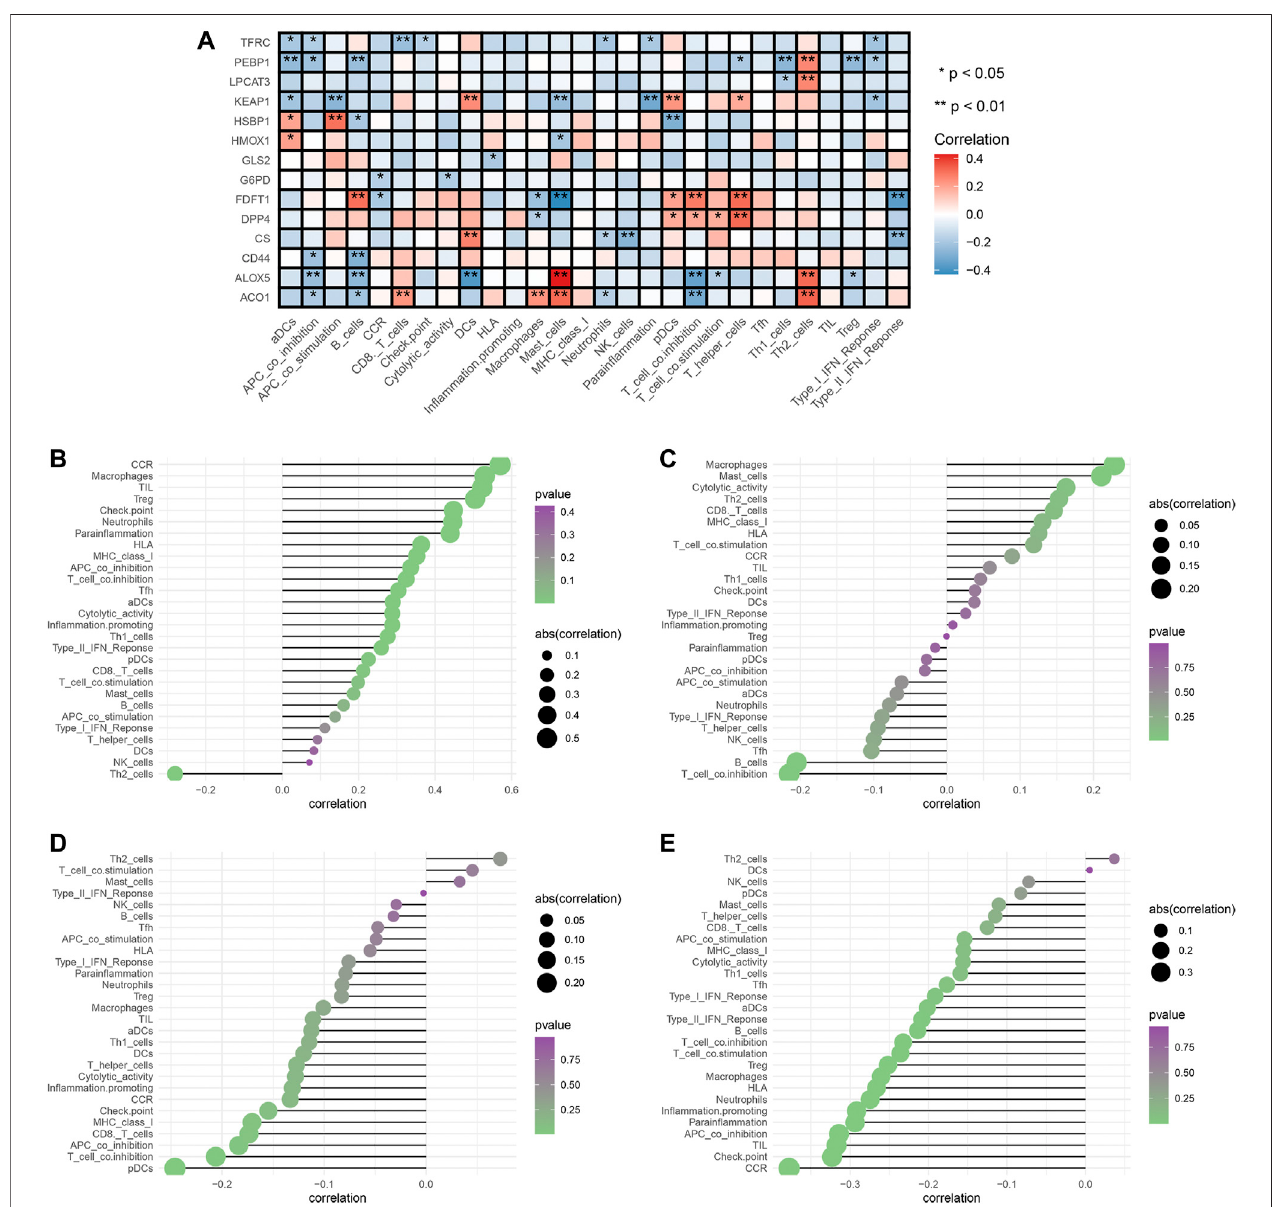
FIGURE 6 | Analysis of ferroptosis-related genes effects on immune signatures. (A) Heatmap was demonstrating the correlation between 14 genes and the ssGSEAscoresof29immunesignatures. (B) HMOX1andimmunesignatures. (C) KEAP1andimmunesignatures. (D) LPCAT3andimmunesignatures. (E) PEBP1and immune signatures. Spearman correlation analysis was used to evaluate the relations with p < 0.05. * p < 0.05; ** p < 0.01. DCs: dendritic cells, iDCs: immature DCs, pDCs: plasmacytoid dendritic cells, TIL: tumor in fi ltrating lymphocyte, CCR: cytokine-cytokine receptor, APC: antigen presenting cells.